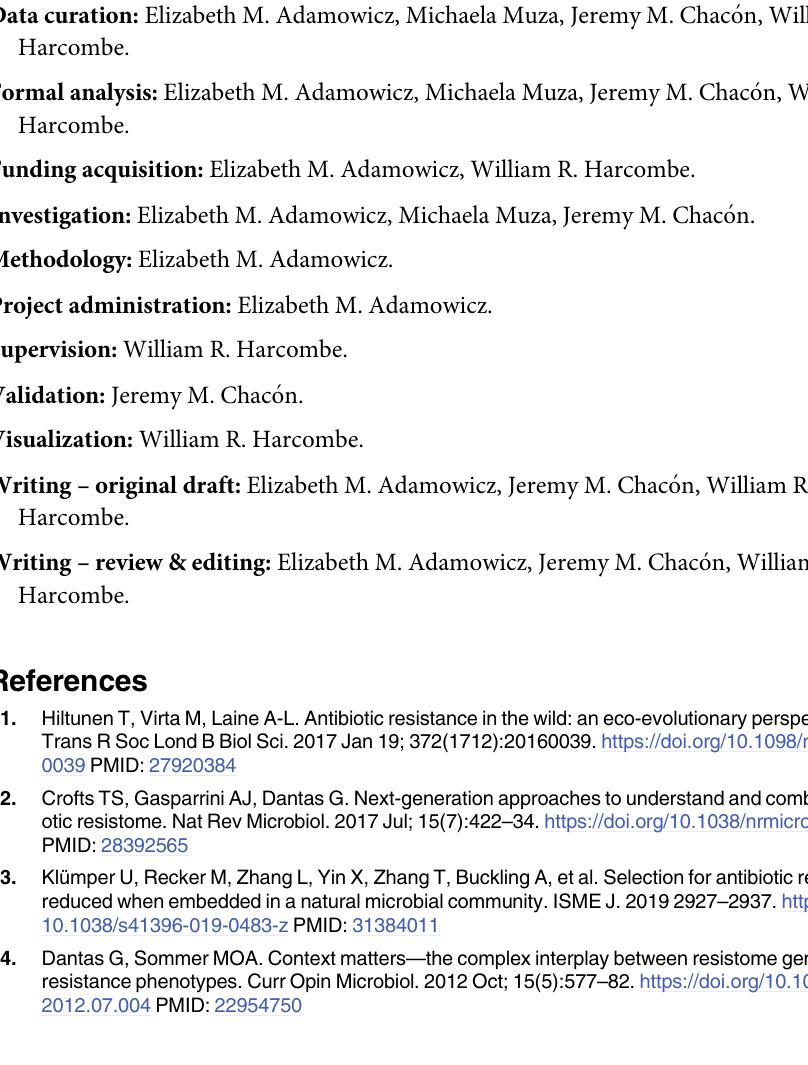
S7 Fig. Average MIC of isolates from each evolved rifampicin ( A ) and ampicillin ( B ) popula- tion. Numbers next to the data points represent population numbers. High-frequency ( > 50%) genotypes can be found in S1 Table . P-values represent Mann-Whitney U test results. (PDF) S1 Code. A zipped file with R code that was used for simulations of antibiotic resistance evolution.